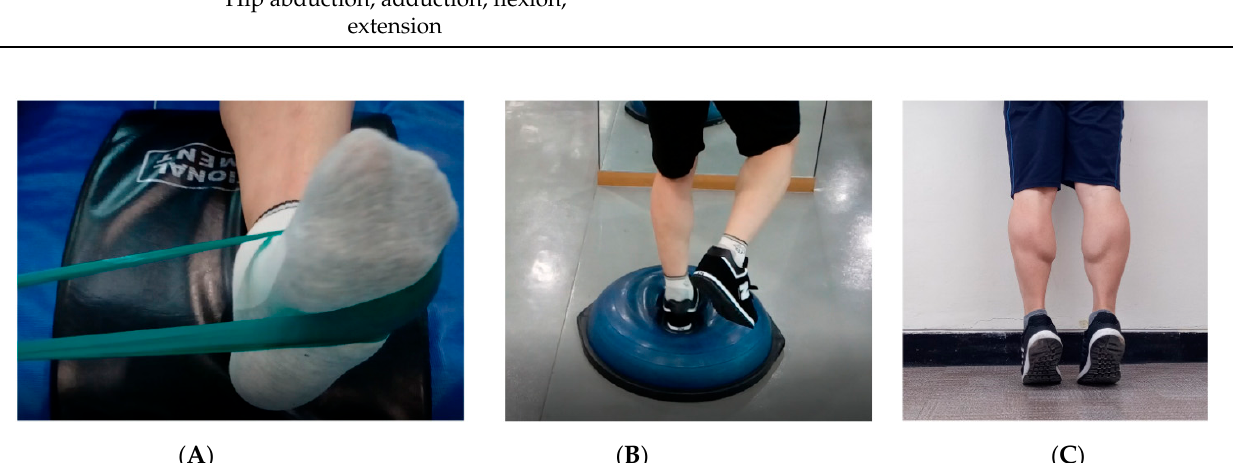
Figure 2. Photographs showing ( A ) ankle strength training with tube band; ( B ) balance training with BOSU; ( C ) heel raise strength training with body